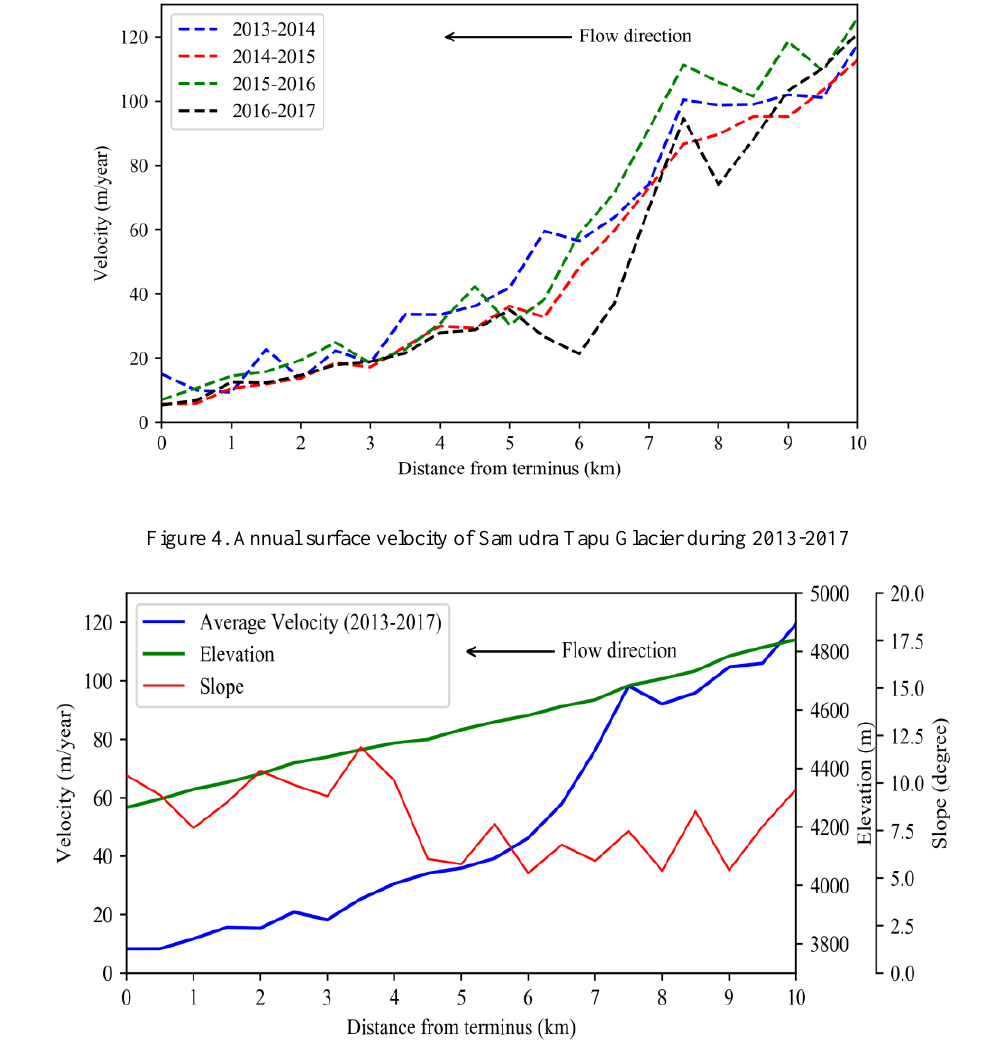
Figure 5. Average Surface velocity during 2013-2017 and its relation with elevation and